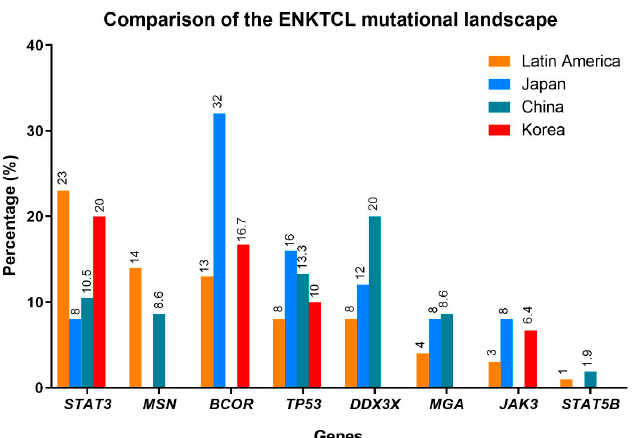
Figure 2. Comparison of the ENKTCL mutation landscape in different populations. The frequency of the mutations of the most common altered genes among these populations is depicted as percentages. The colors indicate the different populations in four different studies: Latin America (orange) [82], Japan (blue) [23], China (green) [22], and Korea (red) [20]. Epigenetic alterations such as methylation in cell cycle regulators, histone modifica- tions, and de-regulated miRNAs are also described. Aberrant promoter methylation is a common oncogenic mechanism in ENKTCL, which induces the silencing of various tumor suppressor genes such as BCL2L11 (BIM), DAPK1, PTPN6 (SHP1), TET2, SOCS6, and ASNS [141], as well as in regulators of the cell cycle such as CDKN2A, CDKN2B , and CDKN1A [140]. EZH2 is a histone methyltransferase, a member of the polycomb repressor complex 2 (PCR2) which controls the DNA methylation of oncogenes and tumor suppres- sor genes acting as a transcriptional repressor. In ENKTCL, EZH2 not only acts as a re- pressor, but also acts as an oncogene, promoting proliferation, invasion and survival through the NF-kB signaling pathway [142–144]. Further key epigenetic regulators are miRNA, small non-coding RNAs capable of inducing post-transcriptional gene regulation acting as oncogenes or as tumor suppressor genes [158–160]. Numerous deregulated miRNA have been identified in ENKTCL, including the downregulated miR-146a, miR- 26a, miR-26b, miR-28-5, miR-101 and miR-363 [144,145], whereas miR21 and miR155 are upregulated probably acting as oncogenes, stimulating proliferation through the AKT and MAPK signaling pathways [137,146]. On the other hand, overexpression of the tumor sup- pressor miR-146a in vitro leads to downregulation of the NF-kB signaling pathway by the inhibition of its target TRAF6, resulting in repressed cell proliferation, induced apoptosis, and enhanced chemosensitivity [145]. The profiling and biogenesis of miRNAs has been studied in various disorders and not only in ENKTCL, because they can be exploited and